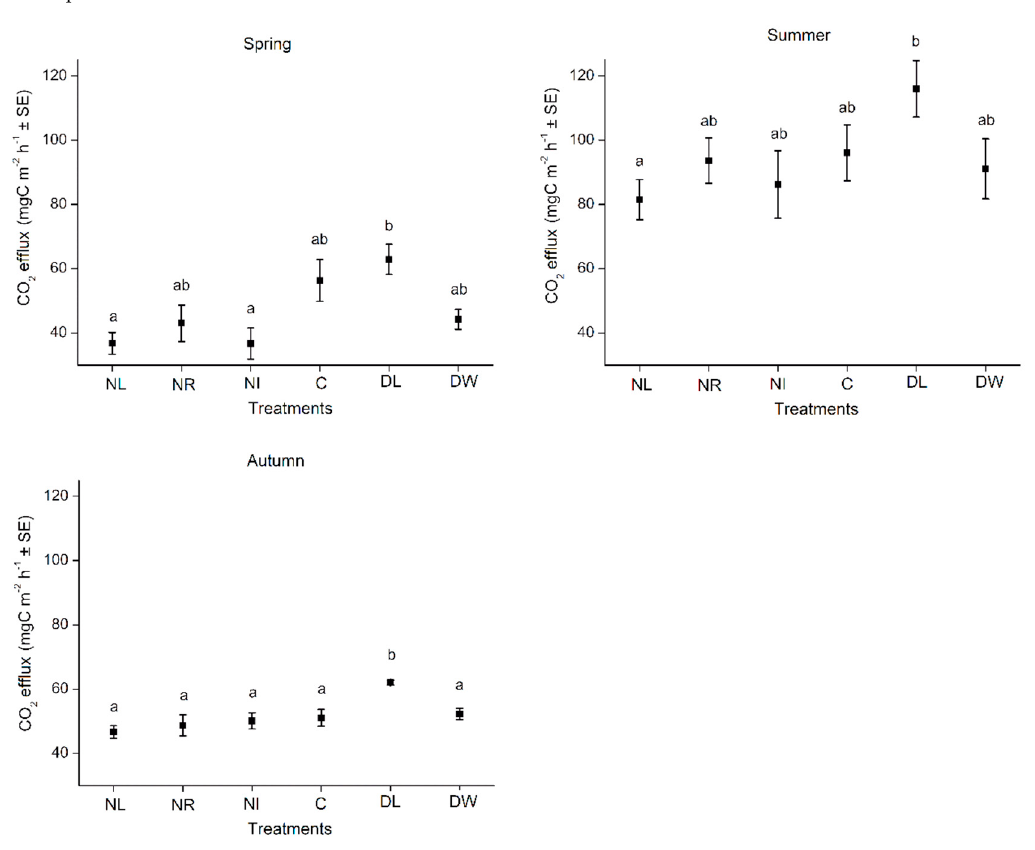
Figure 2. E ff ect of litter treatments with di ff erent DIRT treatments on soil CO 2 emissions by Figure 2. Effect of litter treatments with different DIRT treatments on soil CO 2 emissions by season.